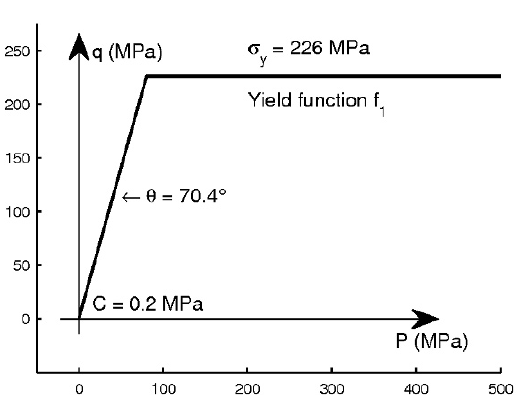
Figure 9. Soil material. Yield function f1 defining shear stress failure versus pressure, σ y = 226 MPa, θ = 70 . 4 °, C = 0 . 2 MPa.